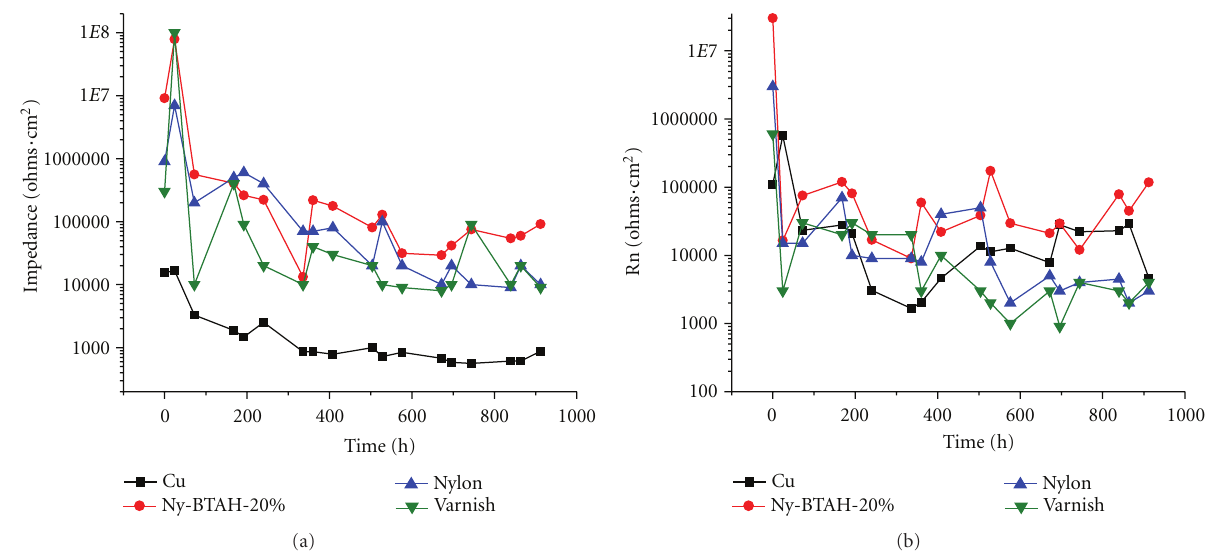
Figure 9: (a) Impedance and (b) noise resistance as a function of time of immersion; for bare Cu, nylon, varnish “only,” and varnish-Ny- BTAH 20% coated copper.